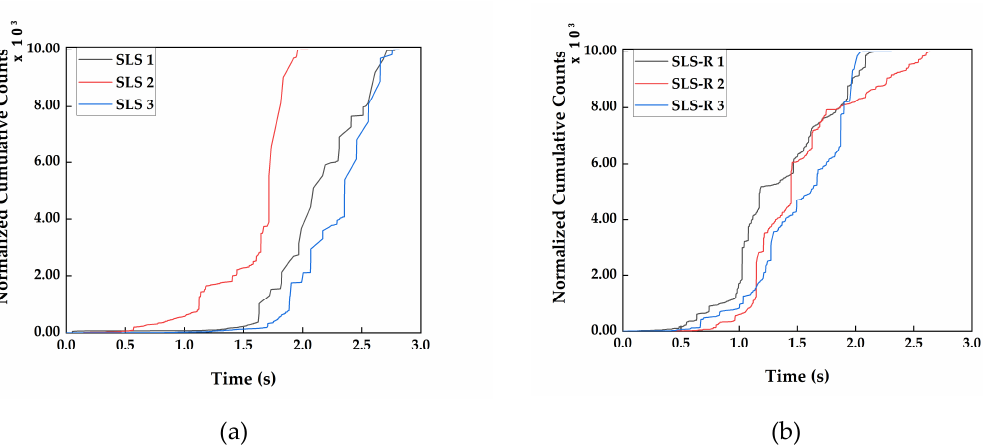
Figure 5. Normalized Cumulative Counts recorded for ( a ) SLS group of specimens, ( b ) SLS-R group of specimens.